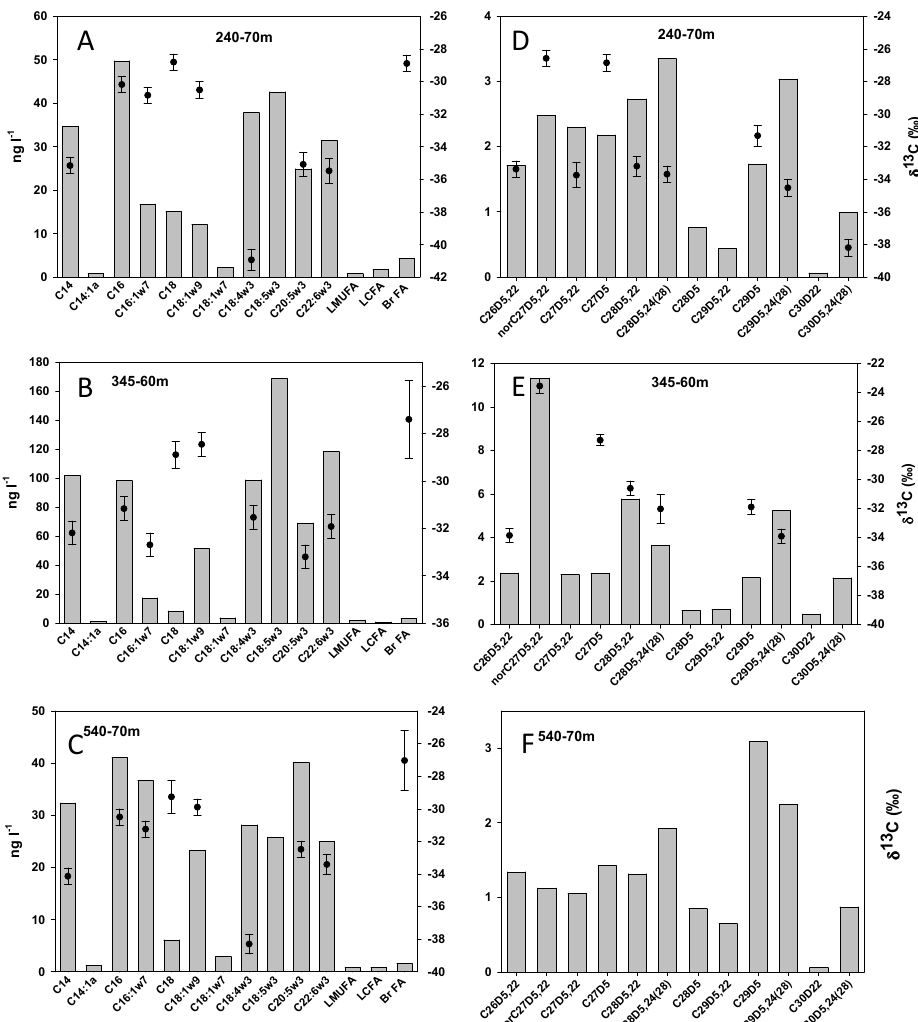
Fig. 4. Concentrations (bars) and carbon isotopic ratios (mean ± SD, n = 3) of selected fatty acids (A–C) and sterols (D–F) in selected SPM from the Mackenzie